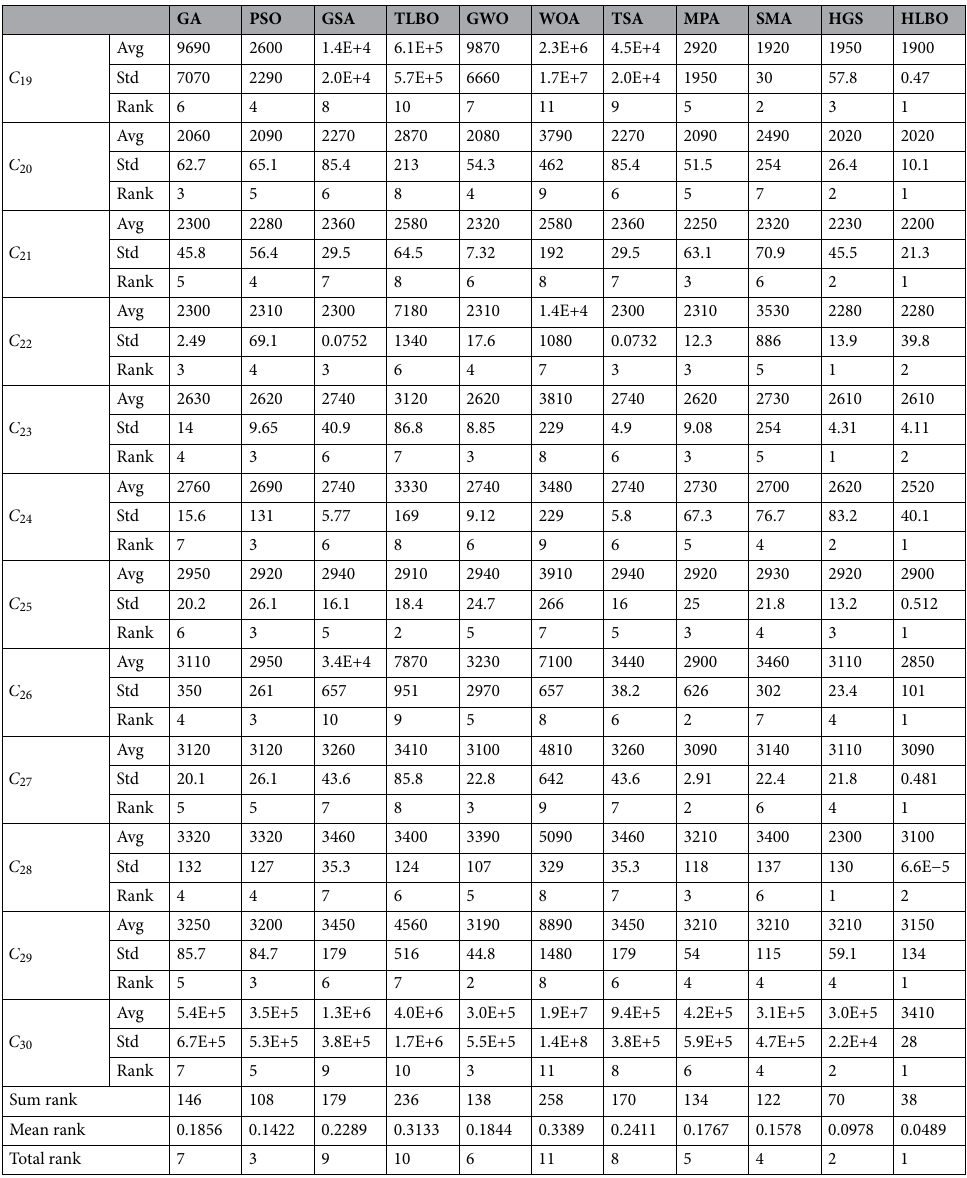
Table 7. Evaluation results of IEEE CEC 2017 objective functions C 19 to C 30